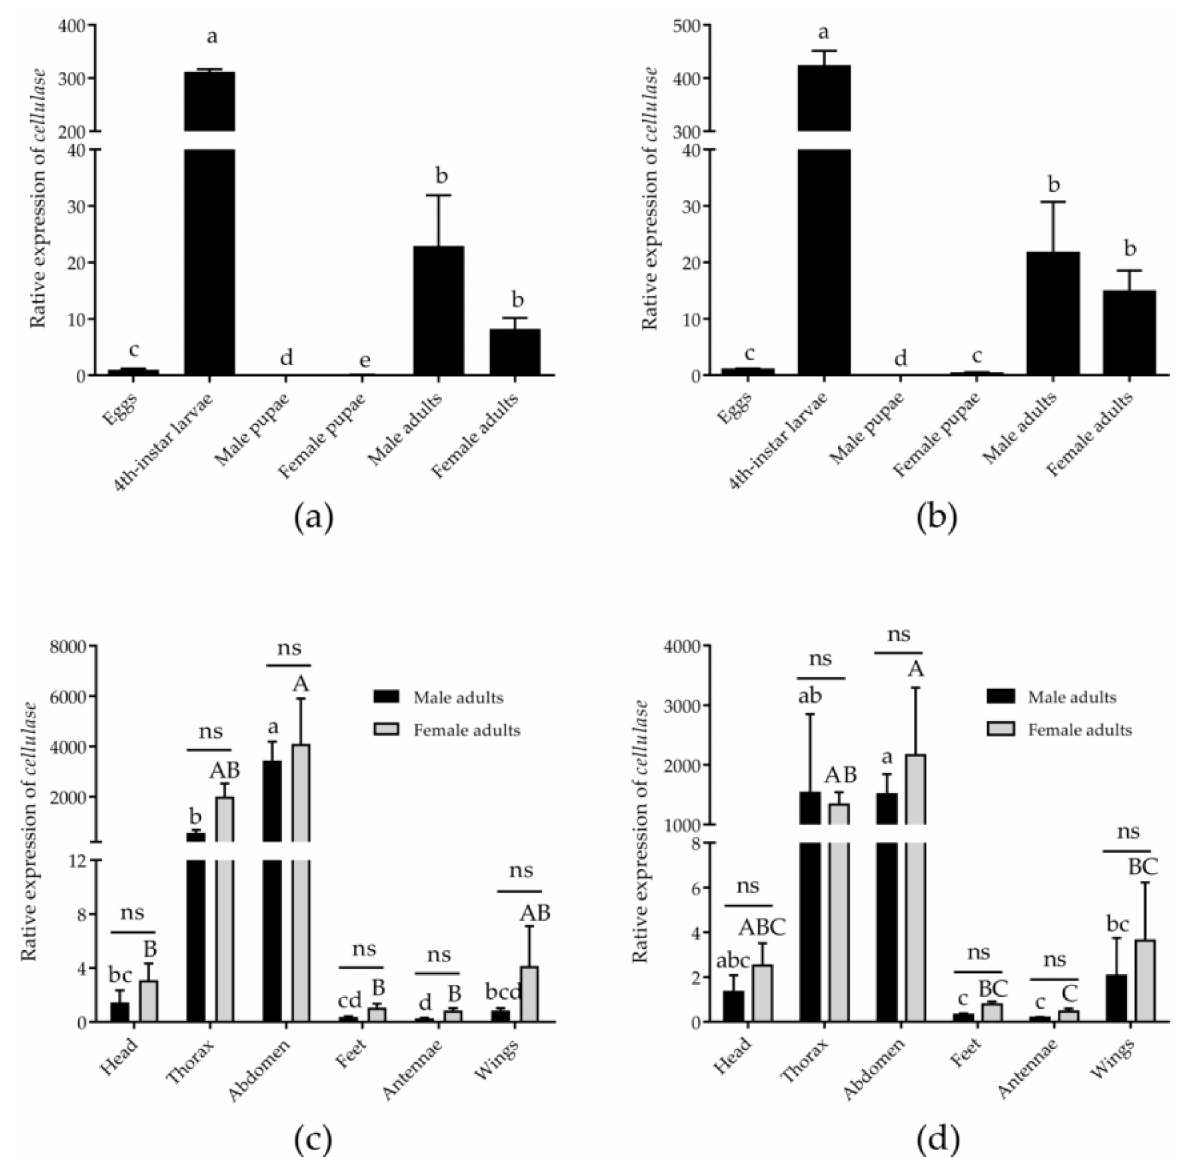
Figure 7. Relative expression level of the target gene ( cellulase ) in the different samples using different normalization factors (the most and least stable genes). Data are expressed as mean ± standard deviation of error. The different large (i.e., A, B, C) and lowercase (i.e., a, b, c) letters indicate that cellulase was significantly different in the female and male tissues ( p < 0.05, one-way ANOVA followed by Tukey’s HSD test). Asterisks indicate the significant differences in the expression levels between the male and female adults in the same tissues, and “ns” indicates no significant differences (Independent Samples t -test). Normalization was performed at the ( a ) different developmental stages by using the most stable genes ( RPL36 and EF1A1 ); ( b ) different developmental stages by using the least stable genes ( RPS20 and 18S ); ( c ) different adult tissues by using the most stable genes ( RPL32 and EF1A1 ); and ( d ) different adult tissues by using the least stable genes ( TBP and 18S ). Note: The representations with the same letters between these groups in the figure weren’t significantly different at p < 0.05. For example, a and b represent between the two groups significant differences at p < 0.05, ab and a represent between the two groups insignificant differences at p <